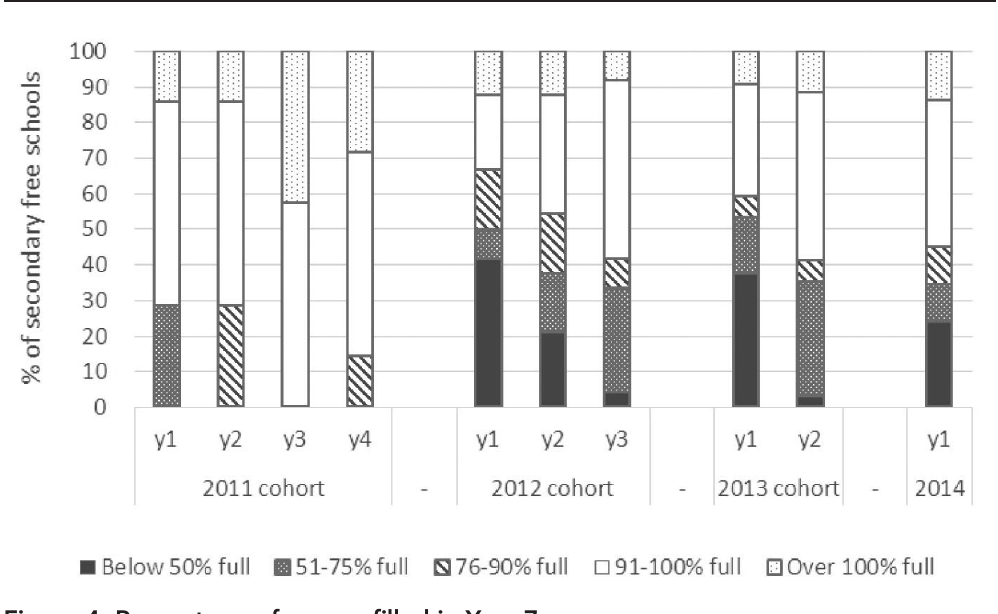
Figure 4: Percentage of spaces filled in Year